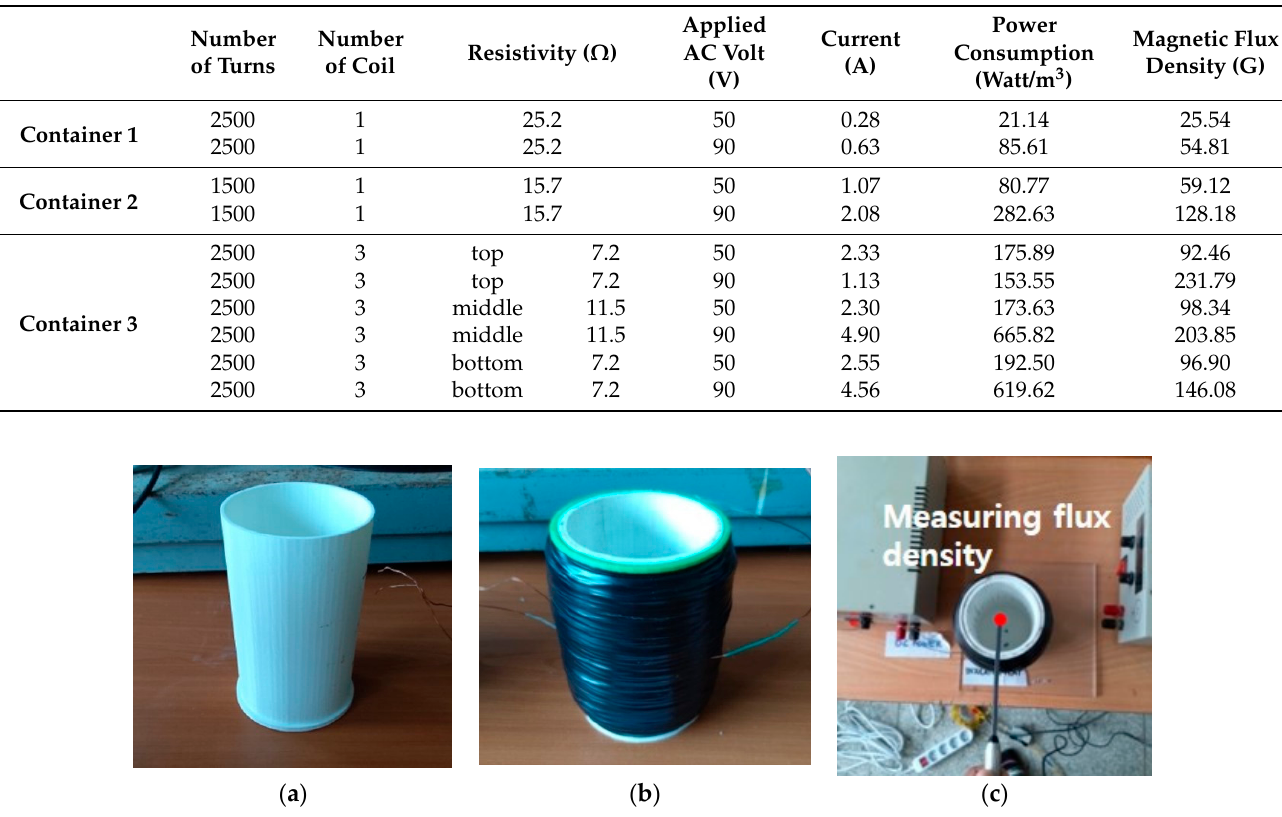
Table 5. Details of winding of coils and measured current and magnetic flux density for each container.